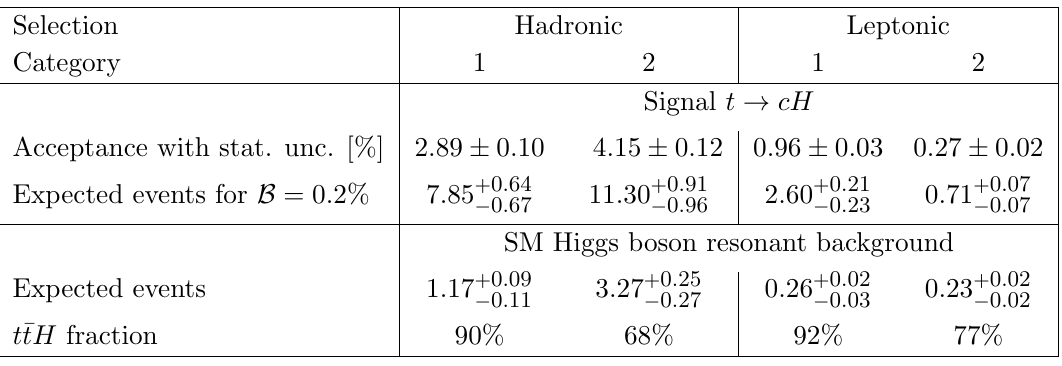
Table 1. Expected acceptances (including e(cid:14)ciencies) for simulated t (cid:22) t events, with t ! cH and H ! (cid:13)(cid:13) . The corresponding expected numbers of events are also shown, together with those for SM Higgs boson production, followed by H ! (cid:13)(cid:13) . The fraction of events from the t (cid:22) tH channel, dominant in the SM contribution, is also given. The uncertainties in the acceptances are only statistical. The uncertainties in the expected numbers of events include statistical uncertainties and theoretical uncertainties in the cross